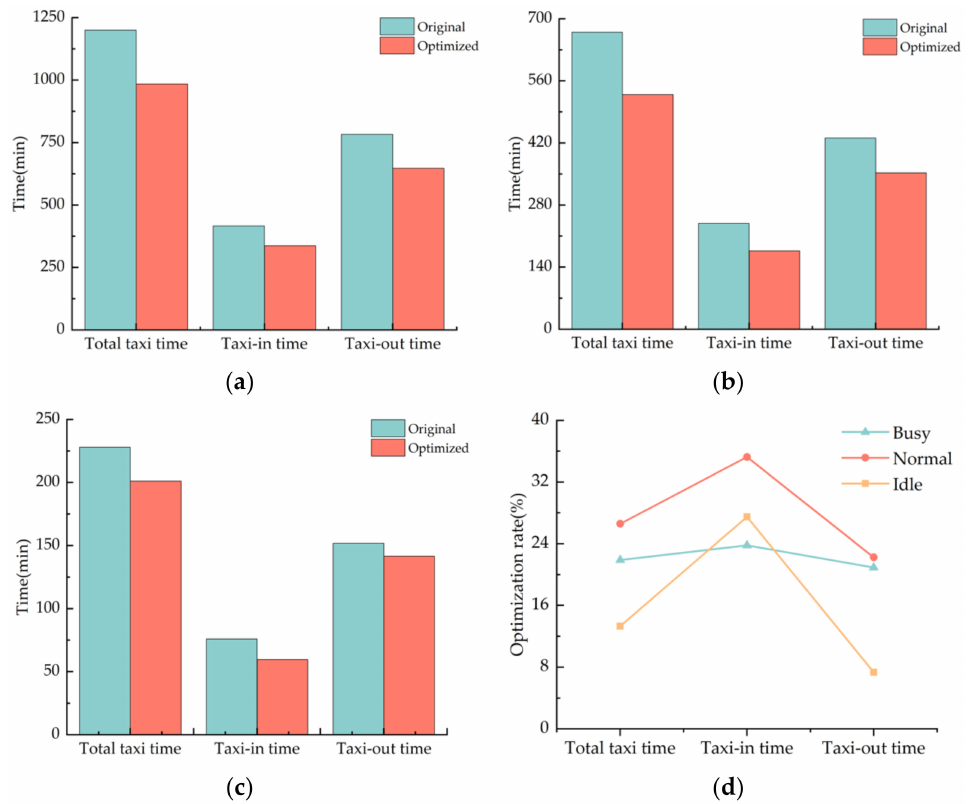
Figure 7. ( a ) Comparison of taxi-in time, taxi-out time, and total taxi time before and after optimiza- tion under Peak scenario; ( b ) Comparison of taxi-in time, taxi-out time, and total taxi time before and after optimization under Normal scenario; ( c ) Comparison of taxi-in time, taxi-out time and total taxi time before and after optimization under Idle scenario; ( d ) Optimization rate of taxi-in time, taxi-out time, and total taxi